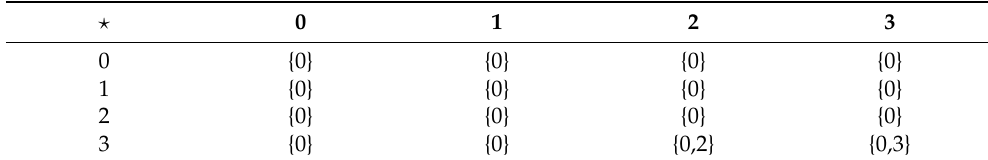
Table 3. The binary hyperoperation (cid:63) on C